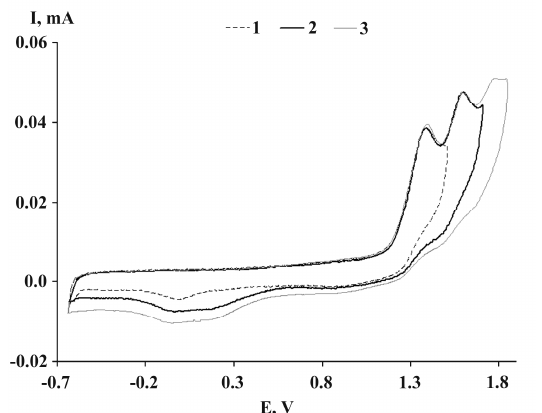
Figure 5. The CV curves of L 2 (in the potential switch from − 0.60 to 1.50 V—curve 1; in the potential switch from − 0.60 to 1.70 V—curve 2; in the potential switch from − 0.60 to 1.85 V—curve 3) (CH 2 Cl 2 , C = 1.5 mM, 0.15 M TBAP, scan rate 200 mV·s − 1 ).